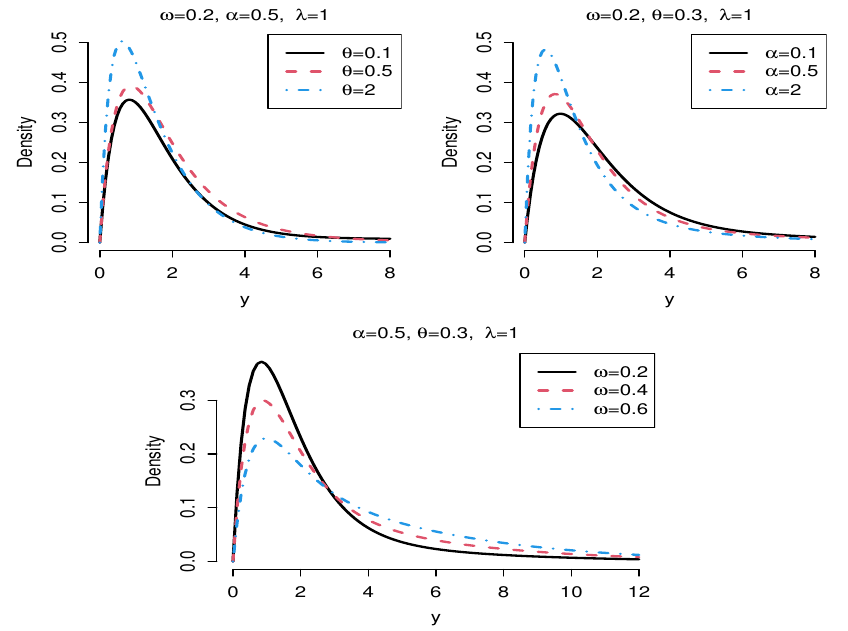
Figure 1. Density plots for different CWE distributions.